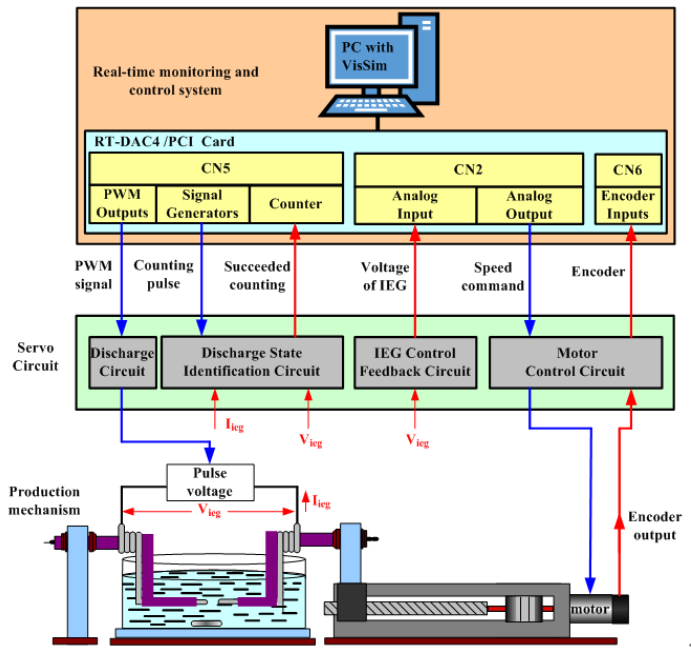
Figure 2. Architecture of micro-EDM system.